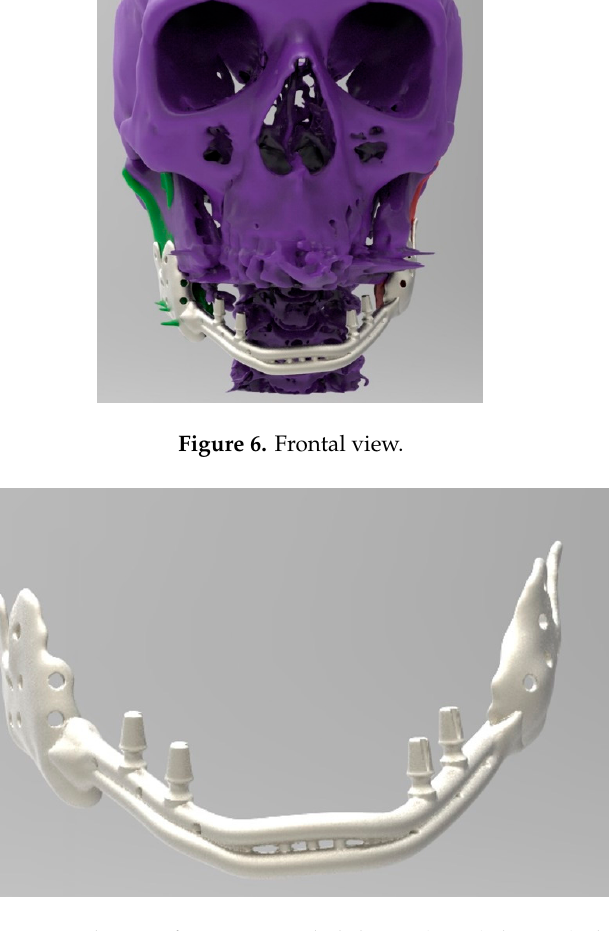
Figure 7. Frontal view of computer-aided-design (CAD) design (.stl file).